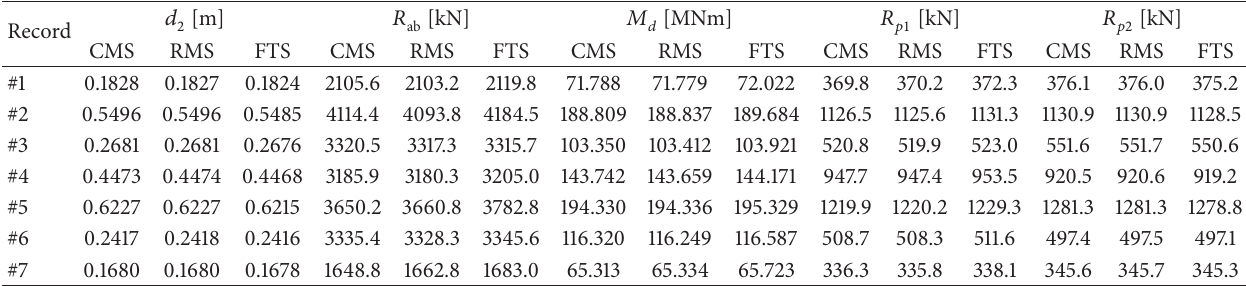
Table 2: Comparison of results according to the different analysis techniques for each of the 7 ground motion records